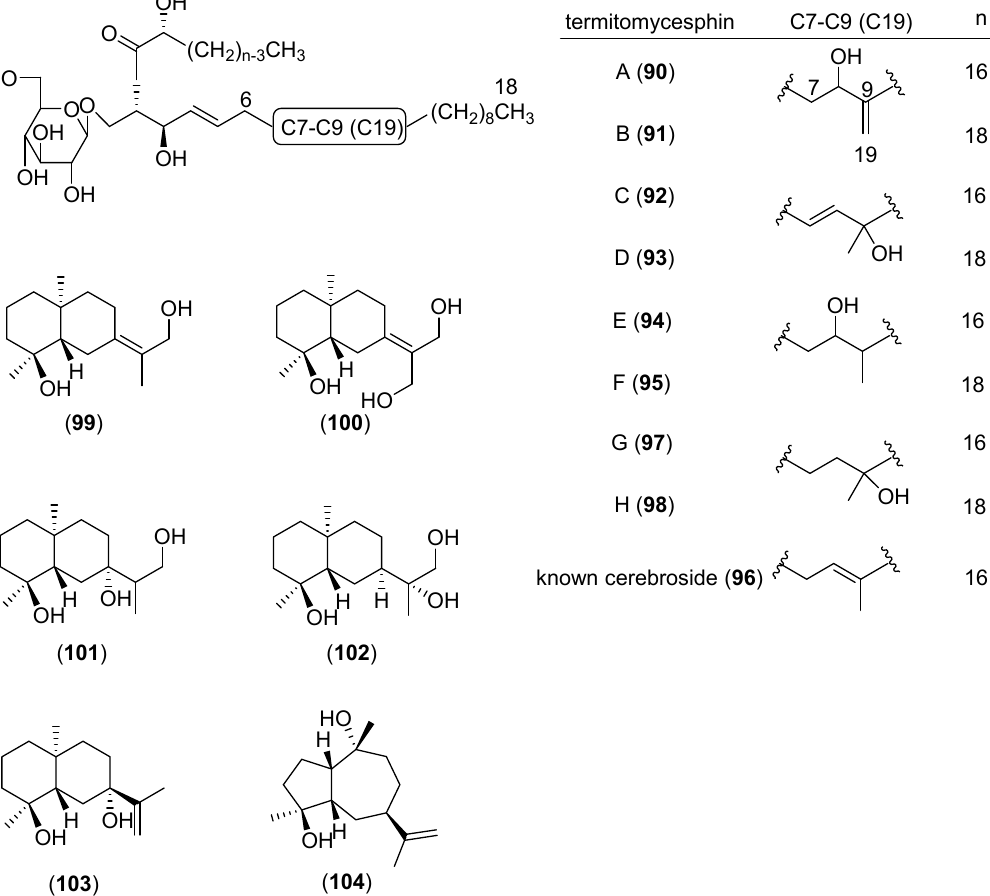
Figure 18. Chemical structures of selected compounds isolated from Termitomyces albuminosus .